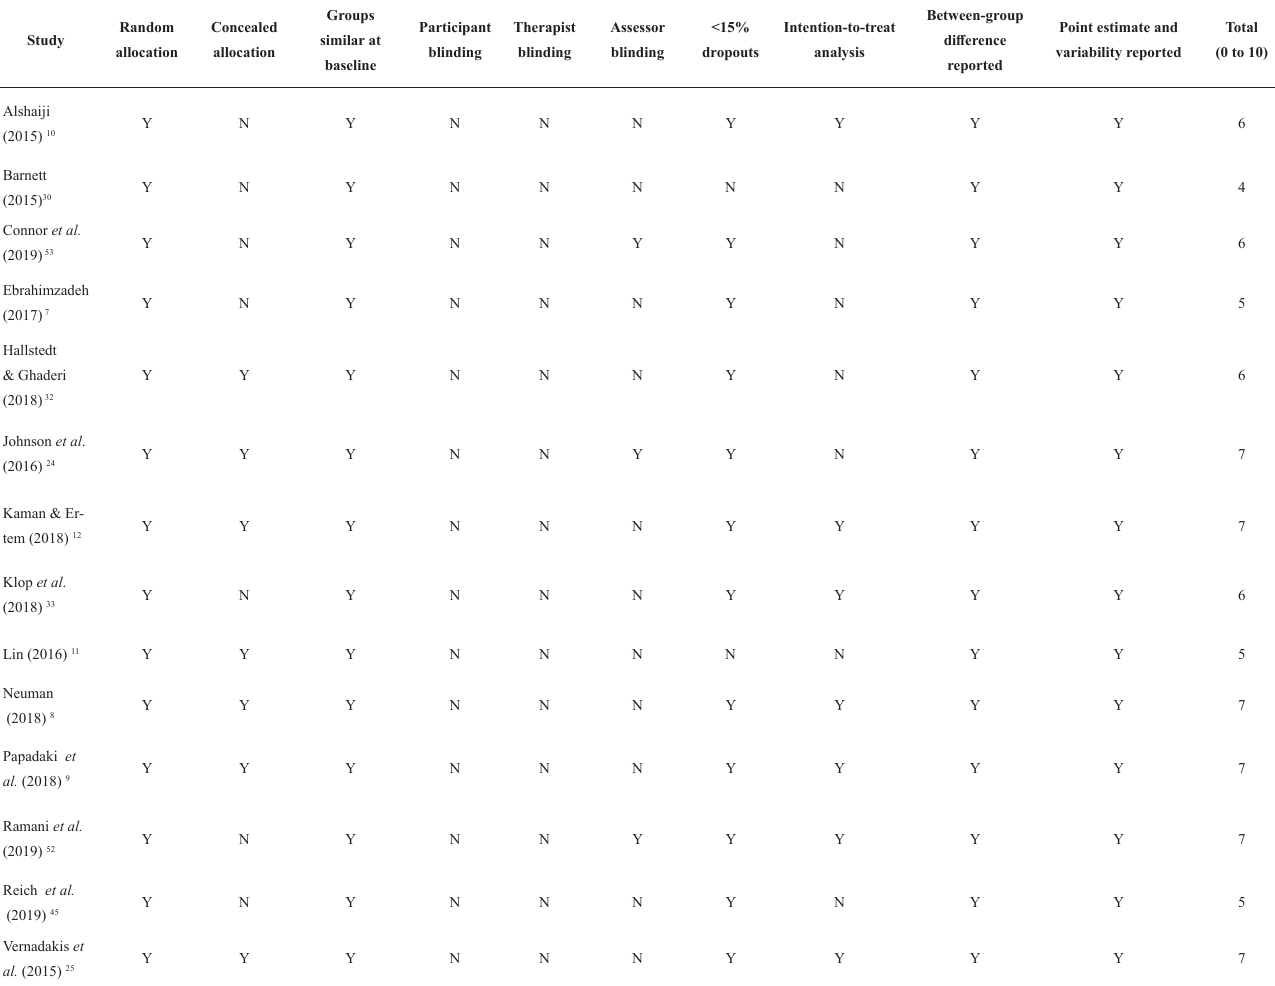
Table 2 - The methodological quality of the included studies using the PEDro scale (n = 14) Random Study